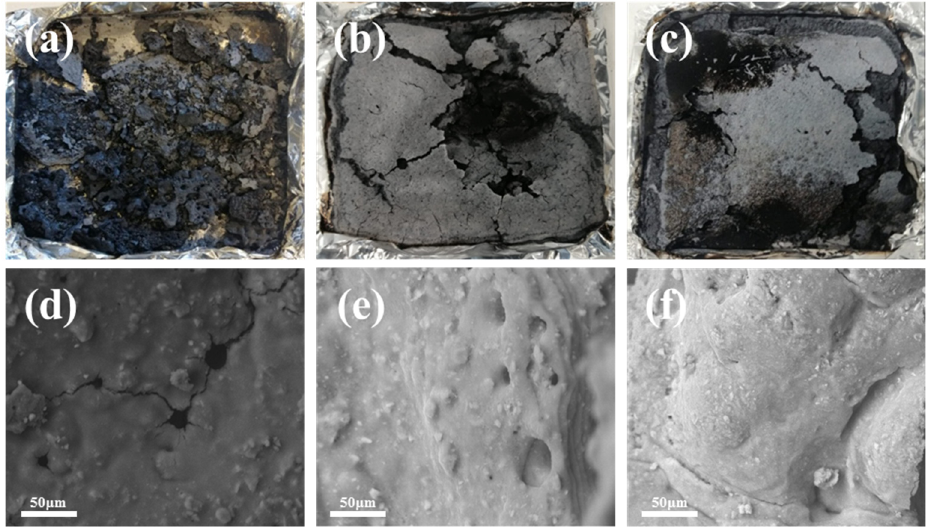
Figure 6. Digital images of chars from EVA composites: ( a ) EVA/55wt%MH; ( b ) EVA/52wt%-